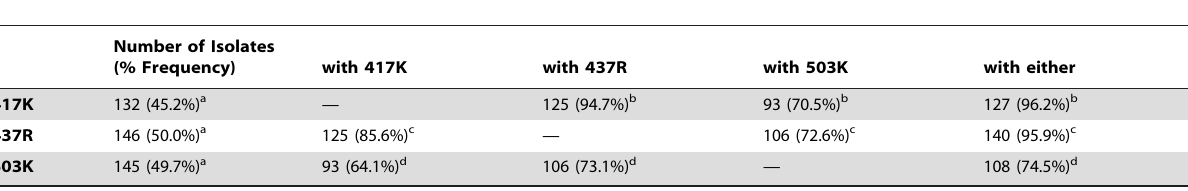
Table 1. Association of polymorphisms N417K, W437R and I503K in 292 PvDBP isolates.